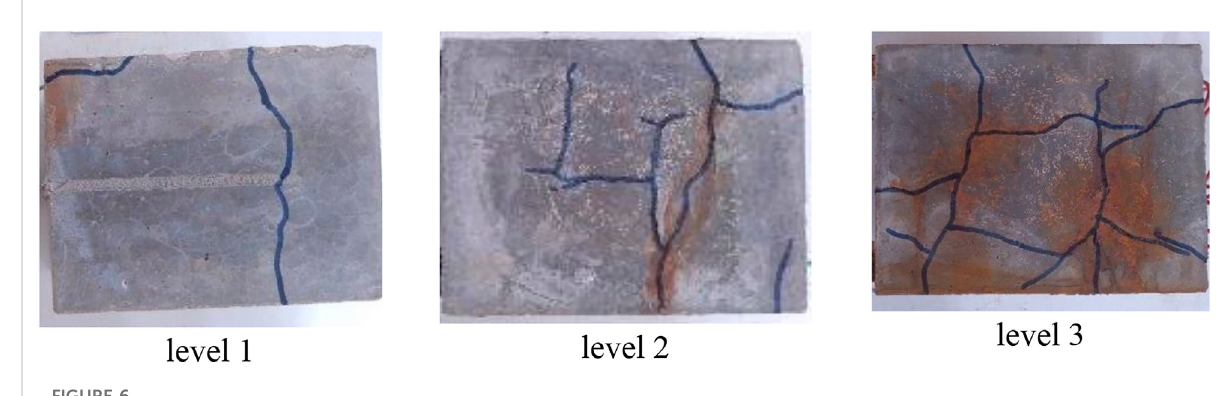
FIGURE 6 Typical crack paterns for different corrosion levels.